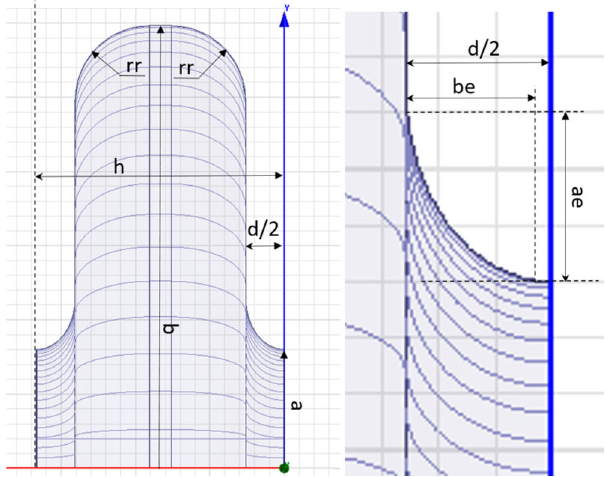
FIG. 8. Cell geometry and parameter definition. On the right the elliptical iris shape is shown in magnified